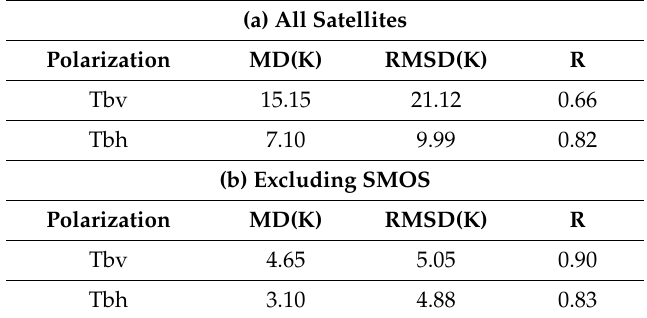
Table 3. Error statistics computed between the observed and simulated Tb.